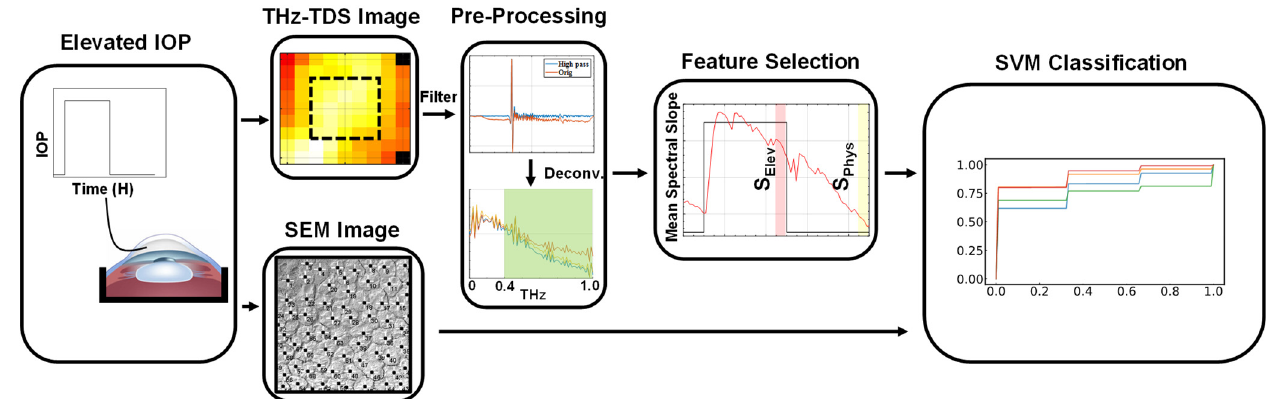
Figure 3. The flowchart depicts the methodology for data collection, signal processing and machine learning classification of the experimental data. The IOP was elevated in porcine ocular globes ( n = 19) to either 25, 35 or 45 mmHg for 4 h before returning the IOP to the physiological levels (15 mmHg) for another 4 h. During this timeframe, THz-TDS images of the samples were captured. At the conclusion of the experiments, SEM imaging was used to assess the intactness of the endothelium. The THz-TDS signals were high-pass-filtered (>0.1THz) and deconvolved. Spectral slopes were obtained in the bandwidth of interest. The mean spectral slope of the central 25 pixels of the selected ROI was calculated. The mean spectral slope of the last 30 min of the elevated and physiological IOP periods, S Elev and S Phys , were used as features for classification using the SVM algorithm.